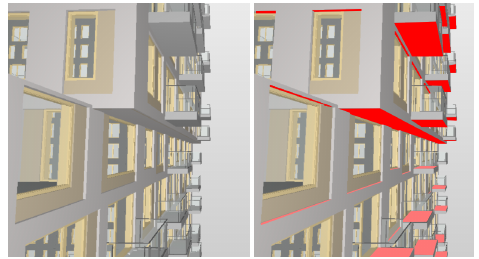
Figure 7. The origin of the two Local systems useful for regulation checks: LocalTotal , with origin in O and LocalOutsite with origin in O i